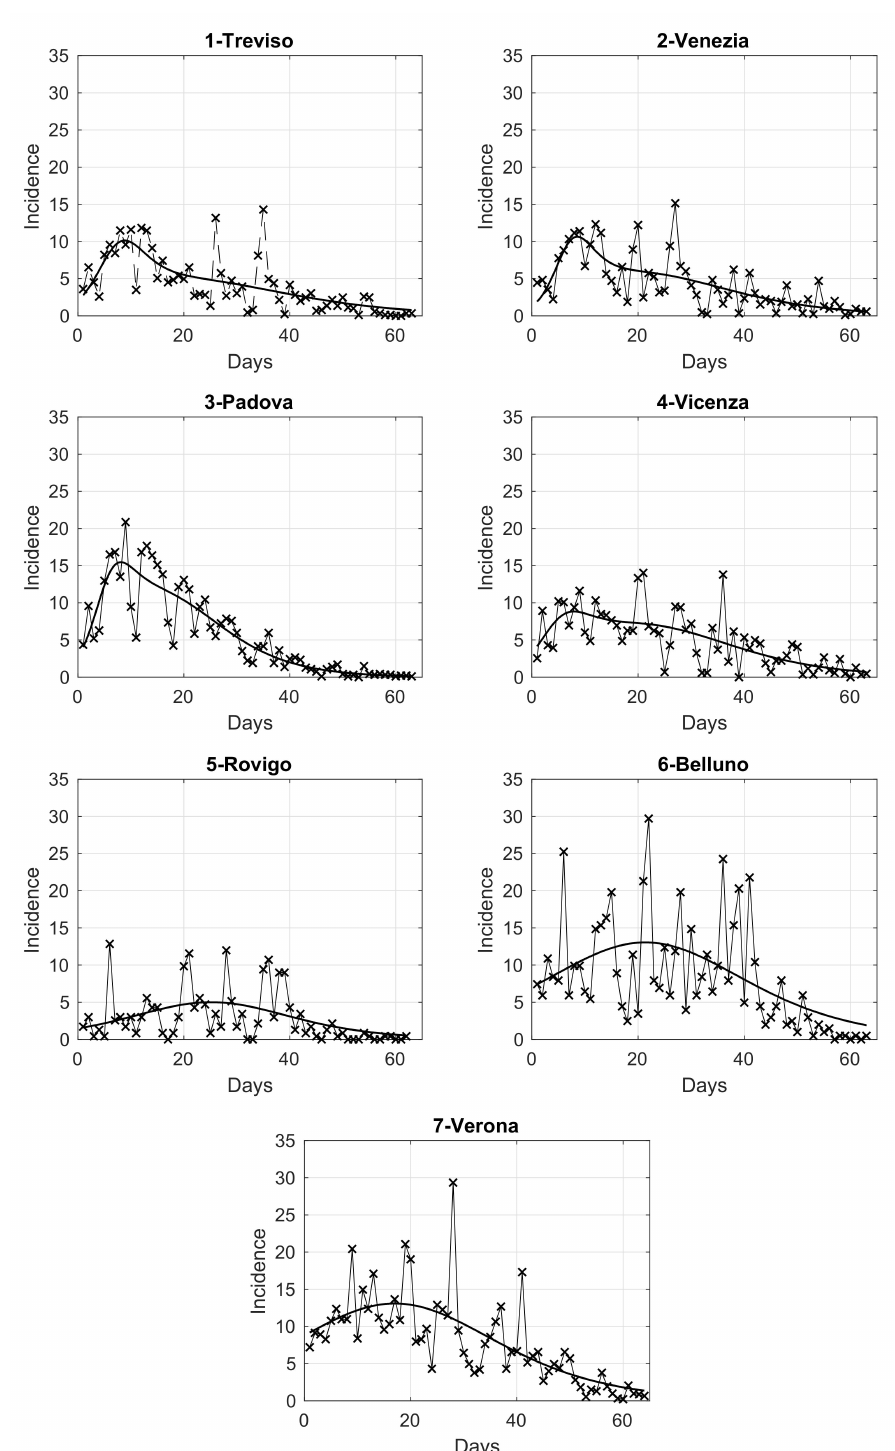
Figure 3. Daily SARS-CoV-2 incidence in the seven provinces of Veneto, relative to the period from 12 March to 15 May 2020, normalized by the corresponding population at 31 December 2019, referred to 100,000 inhabitants. The continuous curve overlapped to the data is the best fit given by the extended logistic